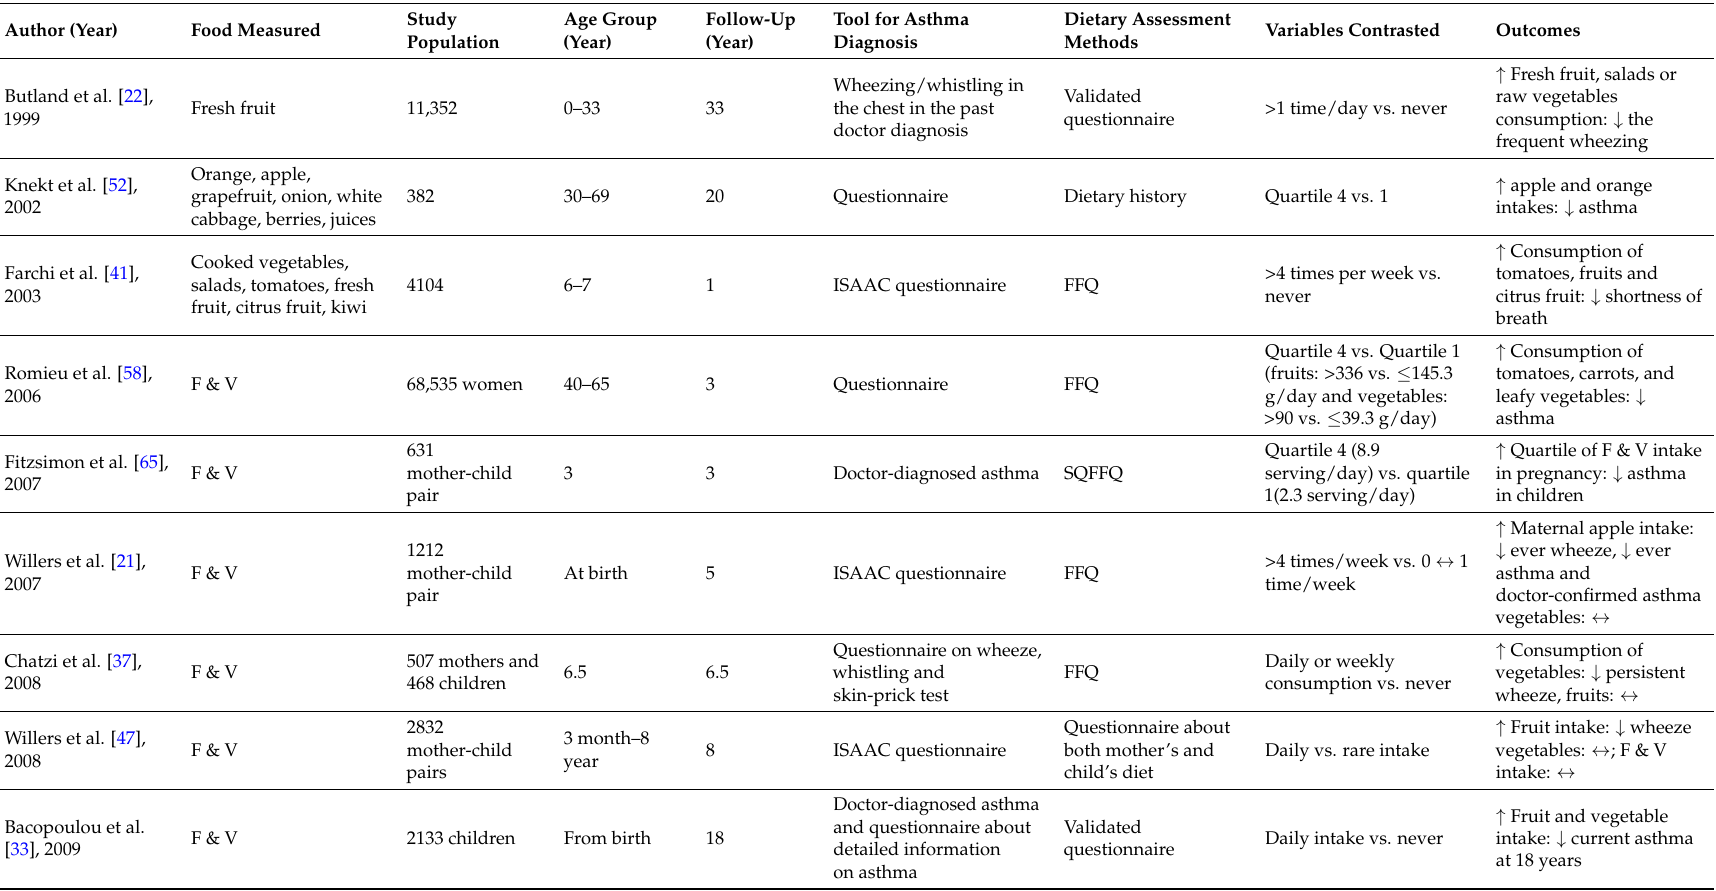
Table 3. Summary of cohort studies on the association between fruit and vegetable intake and